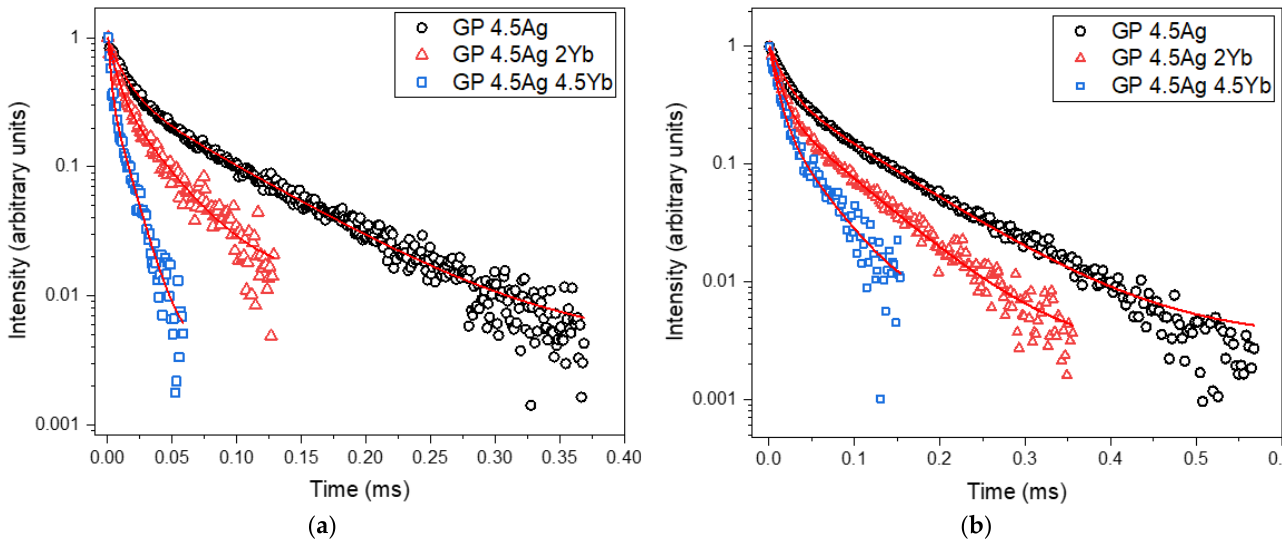
Figure 7 . Ag NCs PL decay curves at 550 nm under ( a ) 355 nm and ( b ) 405 nm excitation for GP 4.5Ag, GP 4.5Ag2Yb, and GP 4.5Ag4.5Yb samples. Table 2 . PL decay lifetimes (fast and slow components) of Ag NCs: GP 4.5Ag, GP 4.5Ag2Yb, and